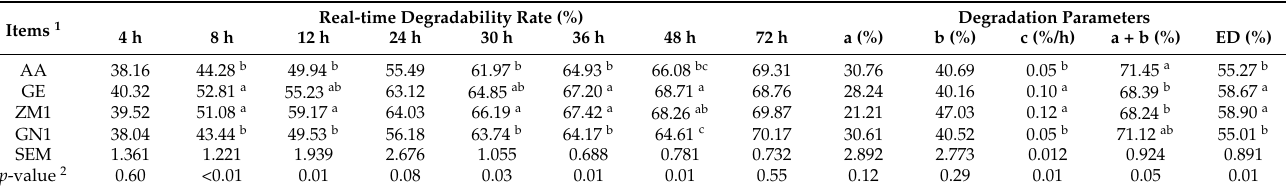
Table 5. Rumen degradable characteristics of DM from various alfalfa hay cultivars